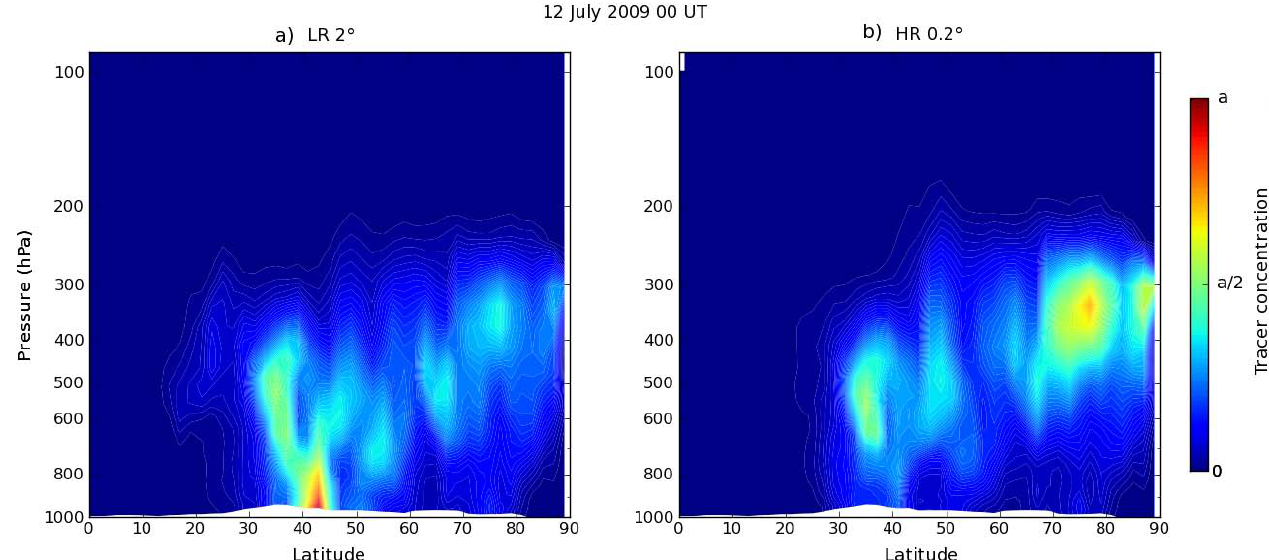
Fig. 11. Zonal means of a tracer initialised backward trajectories. (a) Low Resolution (LR 2 ◦ ), (b) High Resolution (HR 0.2 ◦ ). Tracer concentration values are arbitrary: from 0 to a (the maximum value).